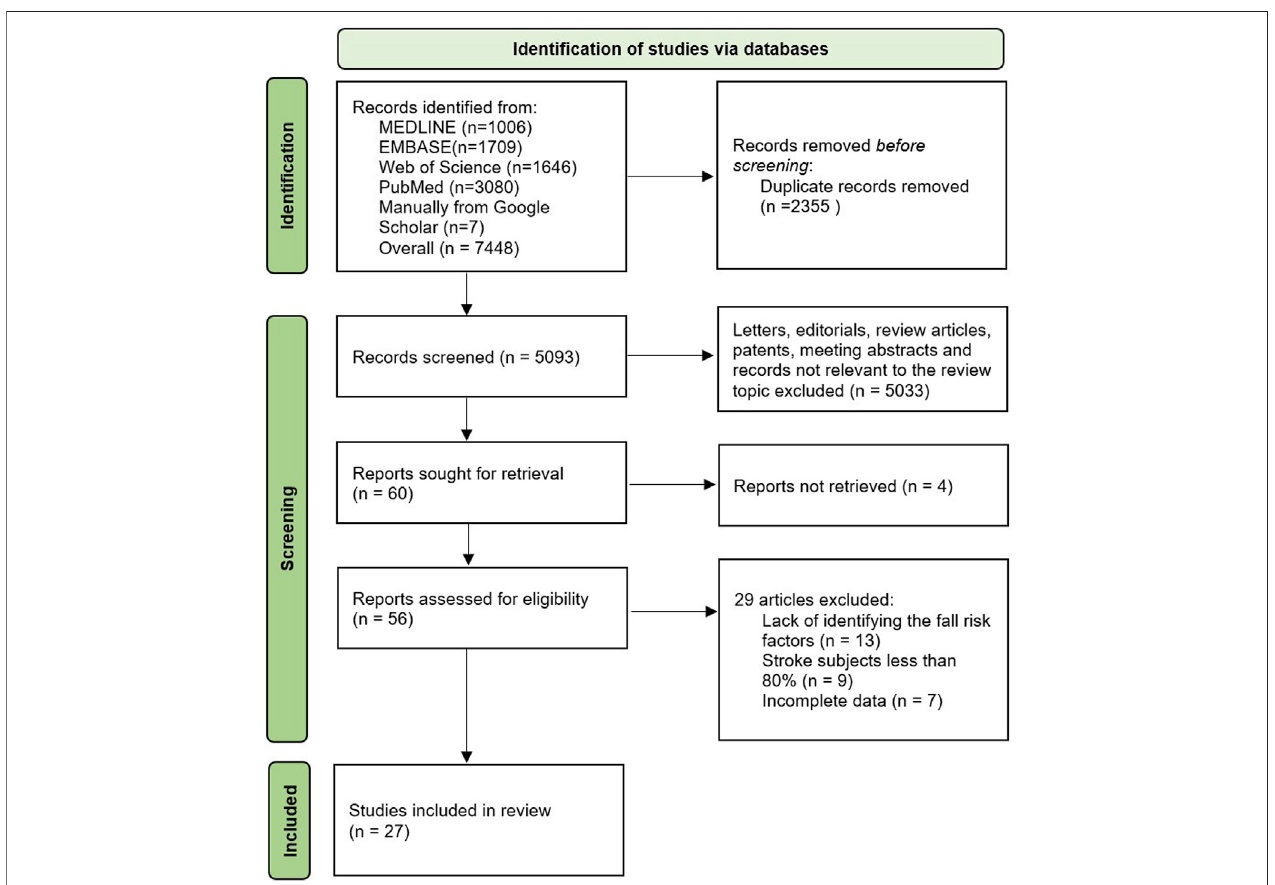
FIGURE 1 | Identi fi cation of the eligible studies to be included in the